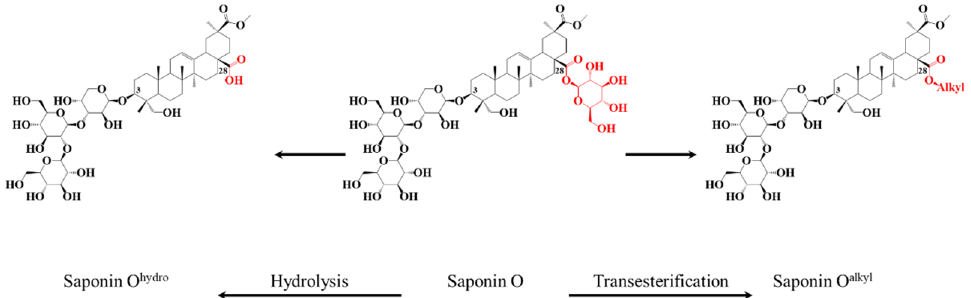
Figure 1. Specific chemical modifications of the bidesmosidic saponins extracted from Chenopodium quinoa husk: (i) hydrolysis of Saponin O to Saponin O hydro , and (ii) transesterification of Saponin O to Saponin O alkyl .